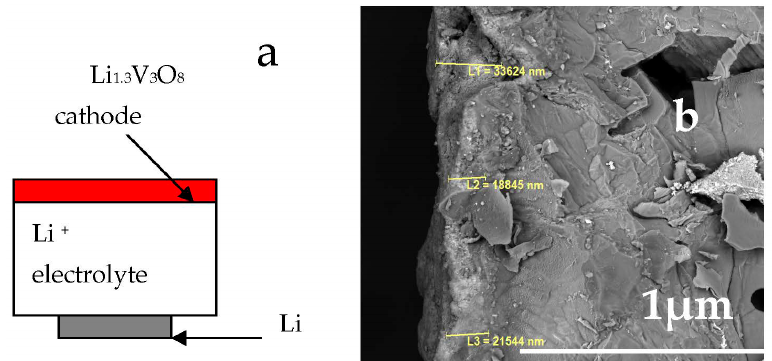
Figure 10. ( a )—cross-sectional schematic of Li | Li 3 . 8 Ge 0 . 9 S 0 . 1 O 4 | Li 1 . 3 V 3 O 8 cell and ( b )—micrograph of the fractured surface of the cell from the side of the cathode.